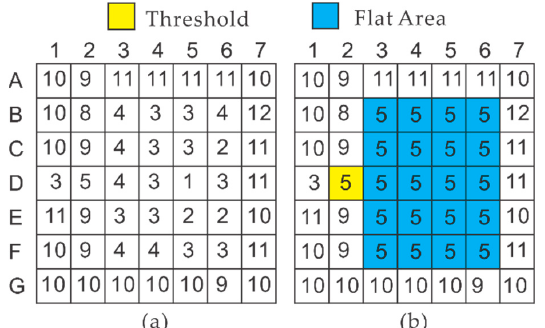
Figure 1. ( a ) Original DEM; and ( b ) DEM after depression filling.